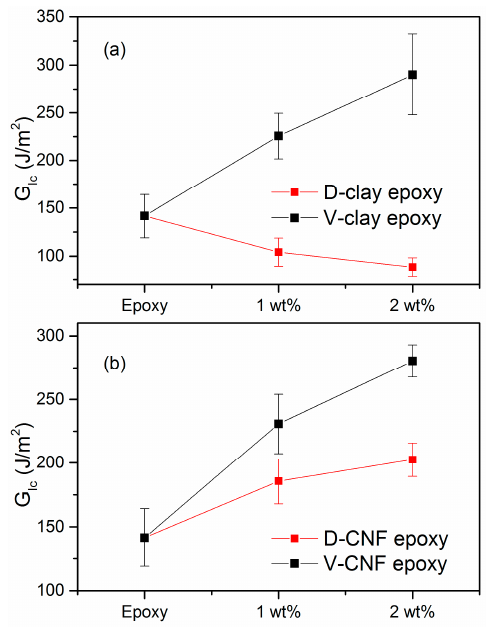
Figure 11. Critical strain energy release rate of nanocomposites with different filler loading ( a ) MMT clay ( b ) CNF.